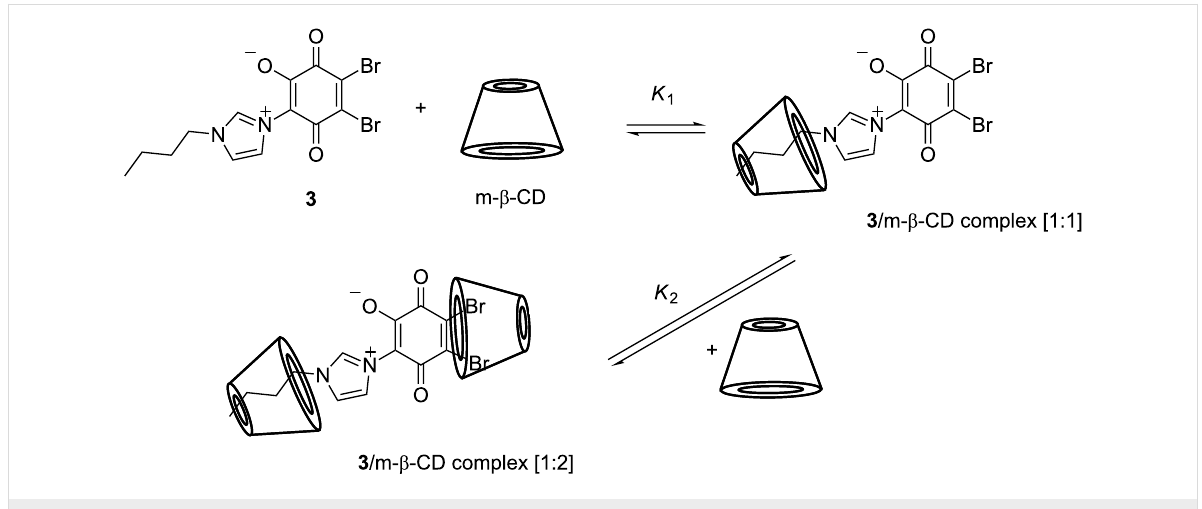
Scheme 2: Mechanism of molecular association of the complex.